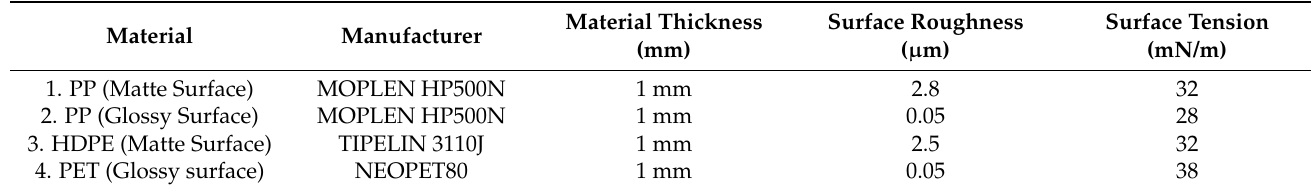
Table 2. Surface characteristics of PP, HDPE, PET materials before